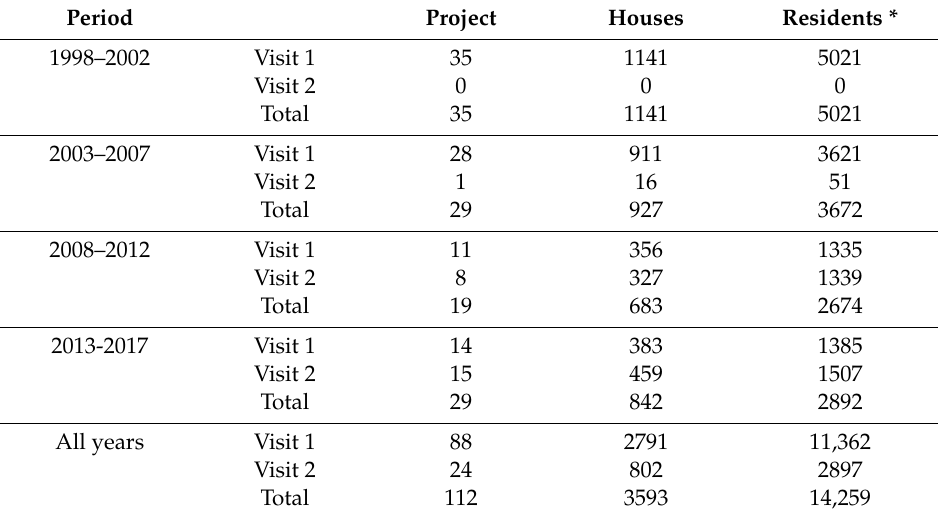
Table 1. Summary results of Housing for Health program data by 5-year intervals.